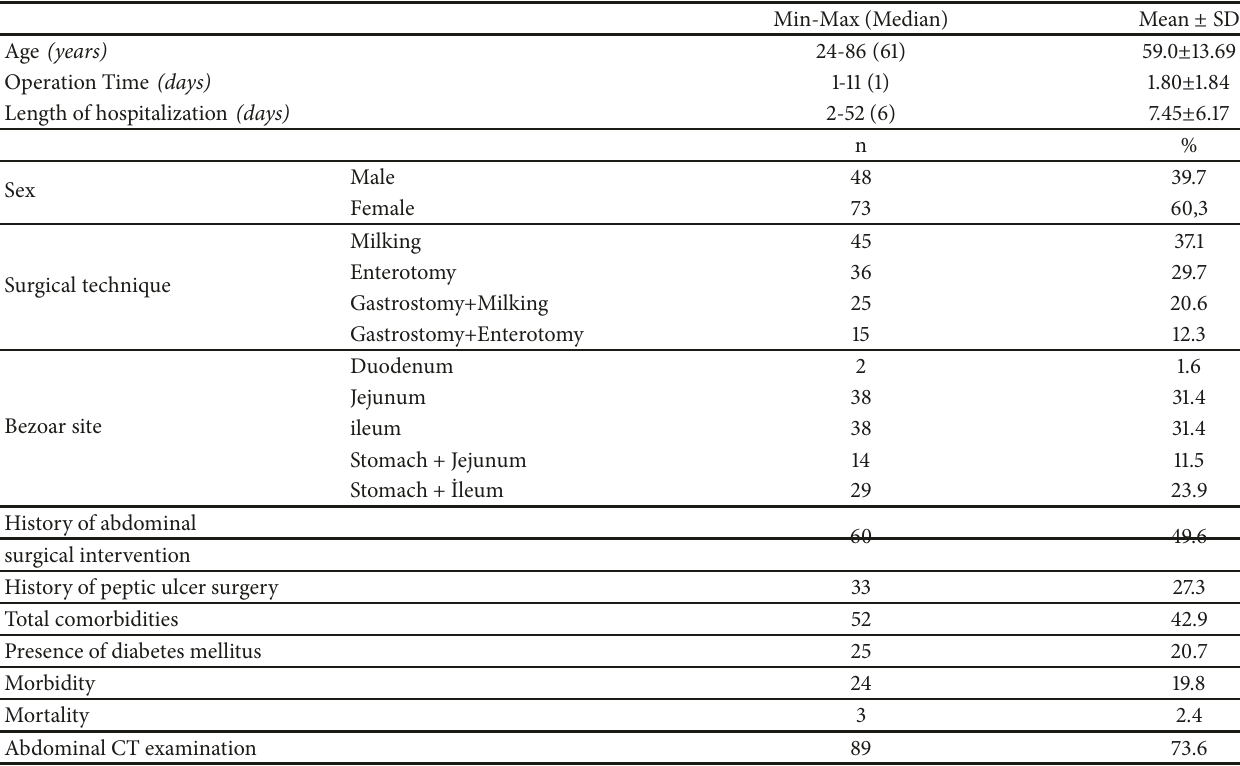
Table 2: Demographic data, bezoar sites, surgical techniques, and morbidity-mortality rates of all